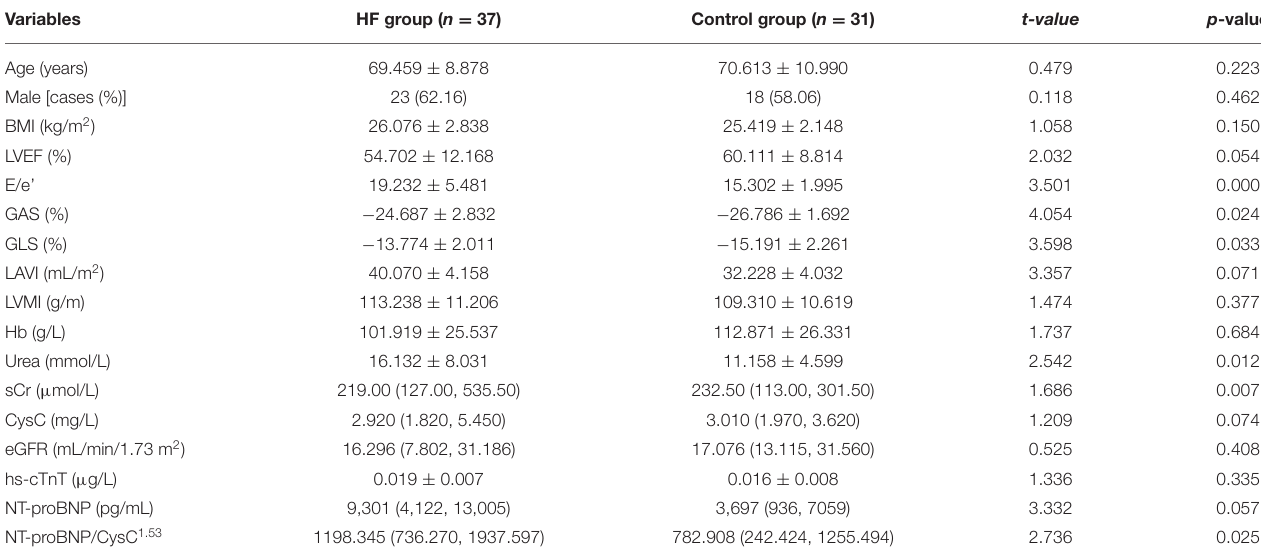
TABLE 2 | Baseline clinical characteristics of CKD patients from another local hospital.